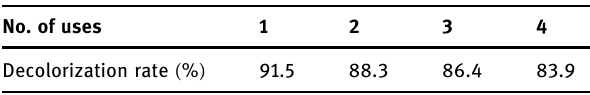
Table 2: Photocatalytic degradation after catalyst reuse for four